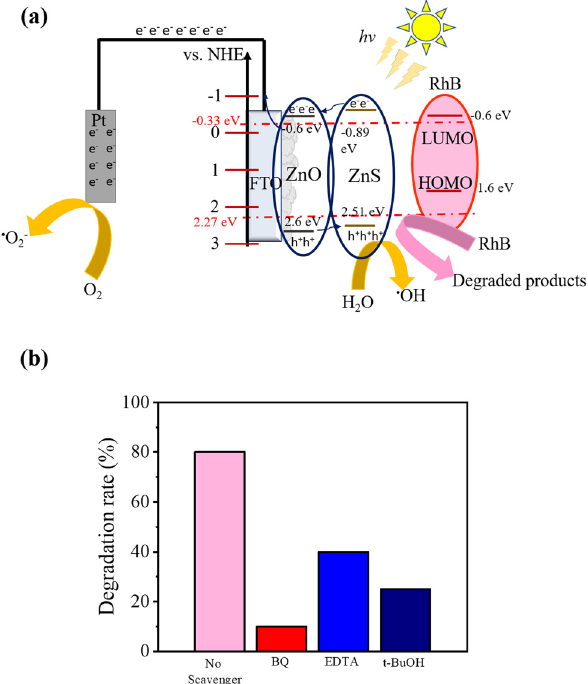
Figure 11: ( a ) The possible band structures and PEC - degradation mechanism of the ZS - 1 toward RhB solution. ( b ) Scavenger tests of the RhB solution containing ZS -